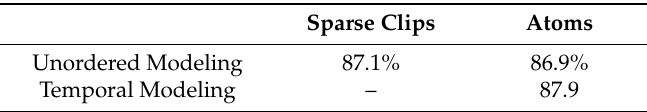
Table 6. The results matrix of the performance evaluation experiment in the RGB stream of 8f temporal scale on UCF101